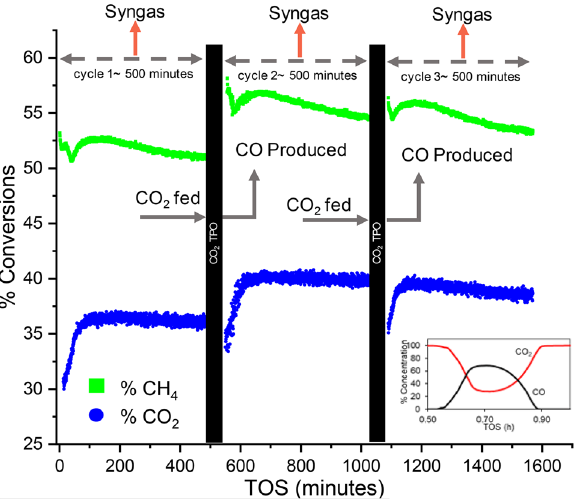
Figure 6. Three cycles of repeatability of the new regeneration technique demonstrating that there is no need for reduction after every surface carbon removal step using CO 2 . Inset figure: Concentration plot from RGA showing the release of CO during CO 2 TPO. Conditions: 200 mg 20% Ni/γ-Al 2 O 3 , flow: 94 mL/min, T: 550 °C.